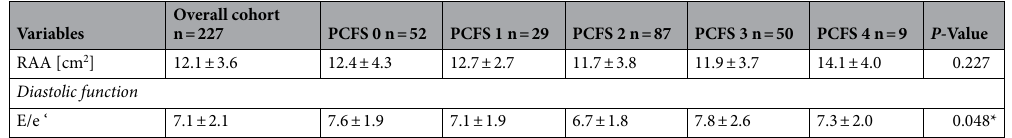
Table 1. Cardiac characteristics and post-COVID-functional-scale (PCFS). Continuous variables are presented as mean ± standard deviation, and categorical variables are presented as absolute numbers and percentages. PCFS post COVID functional scale, ICU intensive care unit, NYHA New York Heart Association, Obesity defined as body mass index > 30 kg/m 2 , O2 oxygen, PHQ-9 patient health questionnaire-9, GAD-7 generalized anxiety disorder-7, PHQ-15 patient health questionnaire-15, MFI-20 multidimensional fatigue inventory-20, hs troponin T high sensitive troponin T, NT-proBNP N-terminal pro brain natriuretic peptide, Anti-RBD antibody against receptor binding domain / spike protein, LV left ventricular, LVEF left ventricular ejection fraction, GLS global longitudinal strain, TAPSE tricuspid annular plain systolic excursion, LAVI left atrial volume index, LVEDV index left ventricular end diastolic volume indexed, RVEDD right ventricular end diastolic diameter, RAA right atrial area, sPAP systolic pulmonary artery